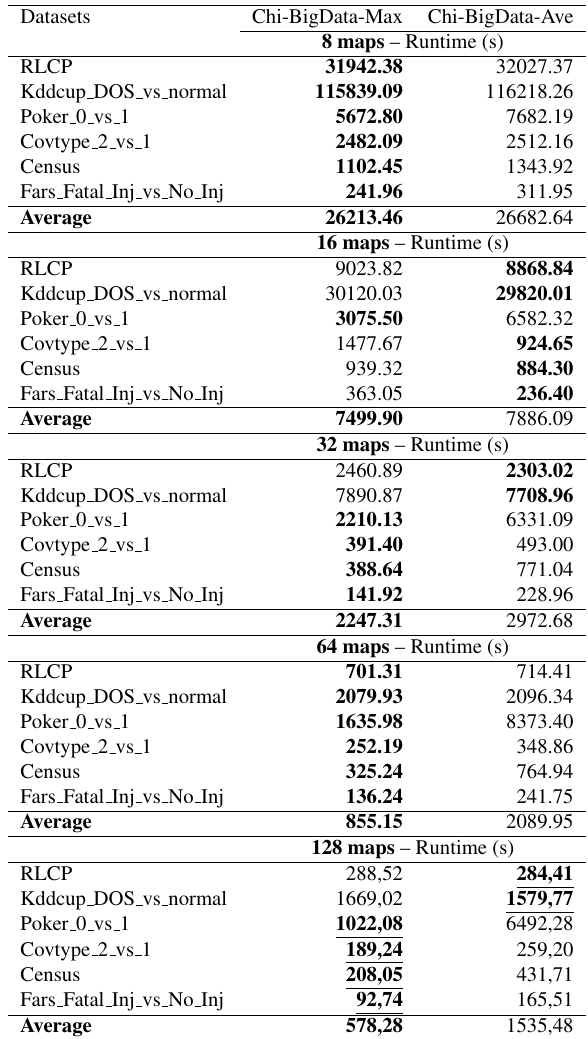
Table 10. Average runtime elapsed in seconds for the Chi- FRBCS-BigData versions using 8, 16, 32, 64 and 128